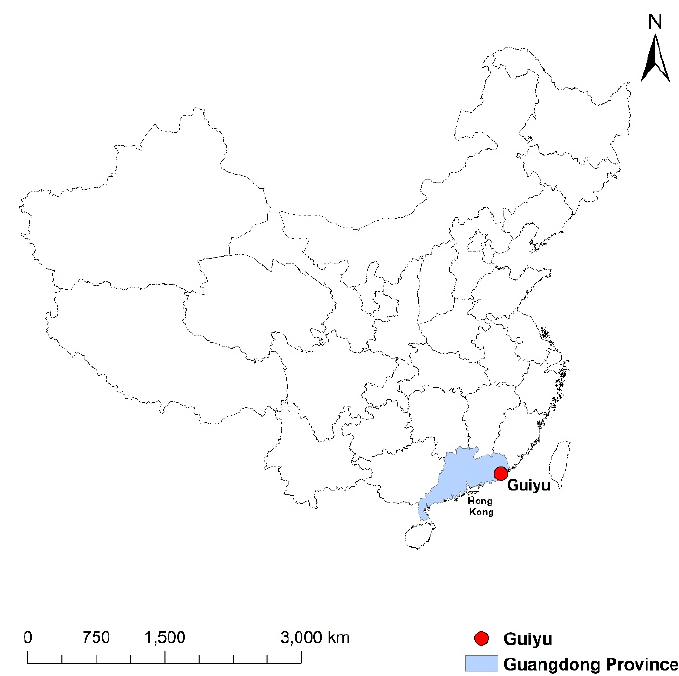
Figure 1. Location of Guiyu in China. (Source: Author).